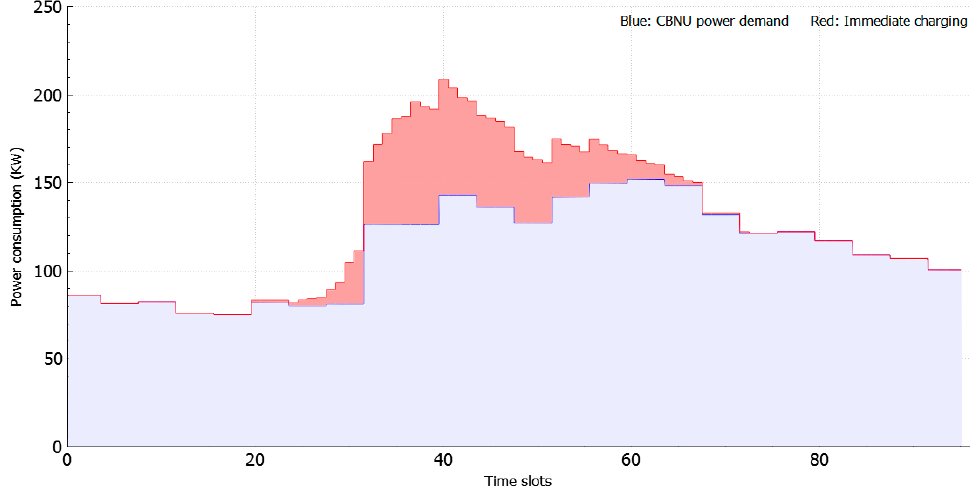
Figure 6. Results of scenario one with immediate charging.